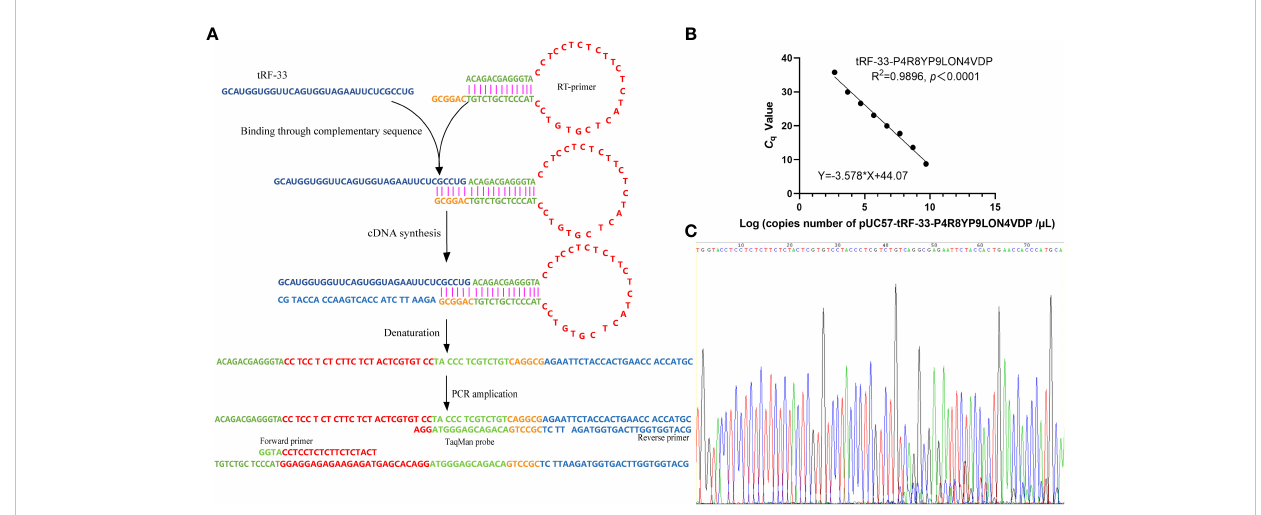
FIGURE 1 Establishment of the detection method for tRF-33-P4R8YP9LON4VDP in plasma. (A) Schematic representation of the method for detection of tRF- 33. (B) The formula for the standard curve. (C) The T – A cloning sequencing results of the qRT-PCR product of